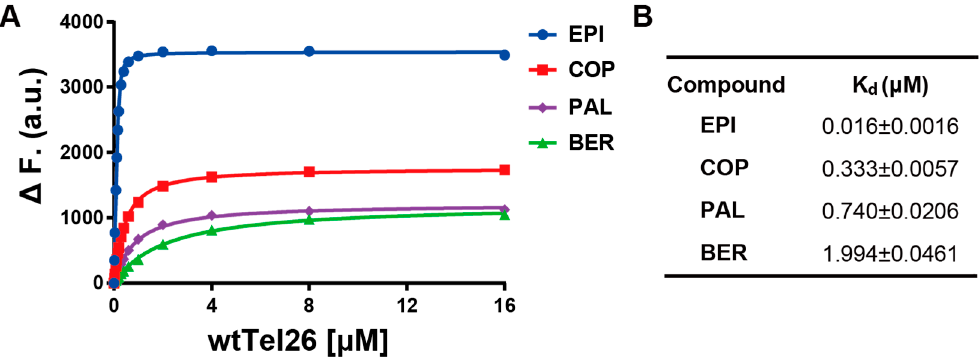
Figure 3. ( A ) Fluorescence intensity of four protoberberines (0.2 μ M) upon titration with wtTel26 DNA, showing 1:1 binding by the curve fitting (solid line). Conditions: 25 °C, pH 7, 100 mM K+. ( B ) The determined disassociation constant (Kd) values of the EPI, COP, PAL, BER.